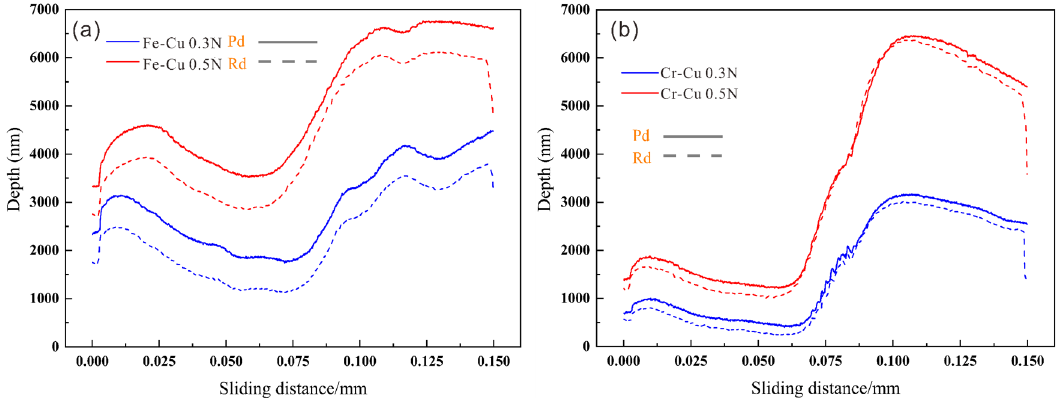
Figure 10. Curves for the h rd , h pd of friction plotted against the sliding distance in the Fe/Cu and Cr/Cu interface regions under different forces: ( a ) Cu/Fe interface regions and ( b ) Cu/Cr interface regions.